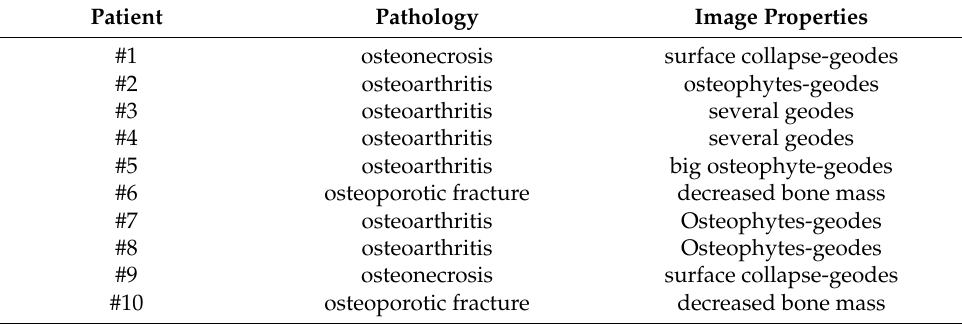
Table 1. Patients’